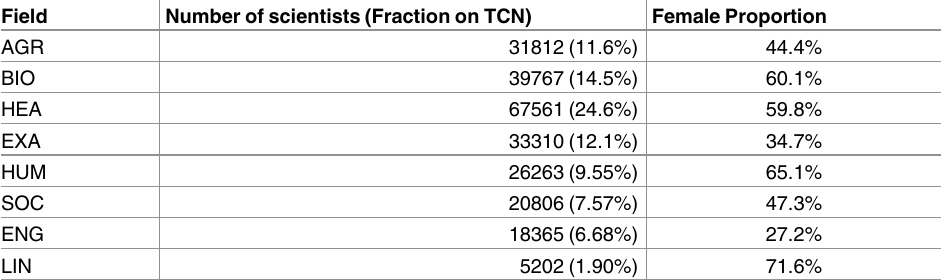
Table 1. Number of scientists, fraction of the Total Collaboration Network (TCN) they represent and proportion of women for each of the eight major fields. The abbreviationsare the same as in Table